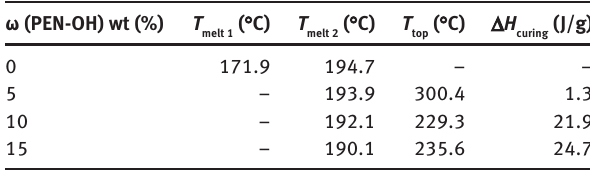
Table 1: Thermal properties of BAPh/PEN-OH prepolymers with various PEN-OH